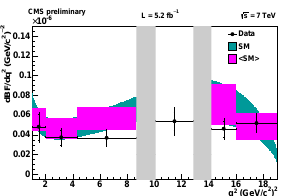
Figure 5. Results of the measurements of d B / d q 2 in q 2 bins. The statistical (total) errors on the data points are represented by the shorter (longer) error bars. The gray regions correspond to the J /ψ and ψ (cid:48) bins. The SM prediction is given by the cyan band. The average SM prediction for each q 2 bin is shown by the magenta boxes.